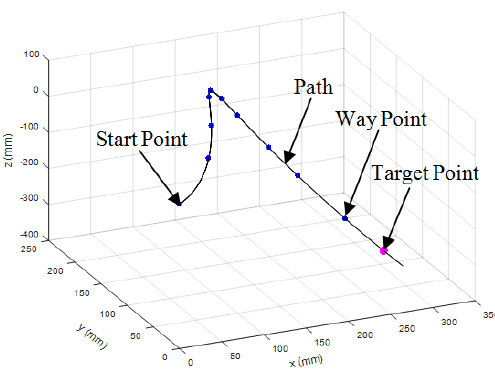
Figure 13. Spatial path curve.